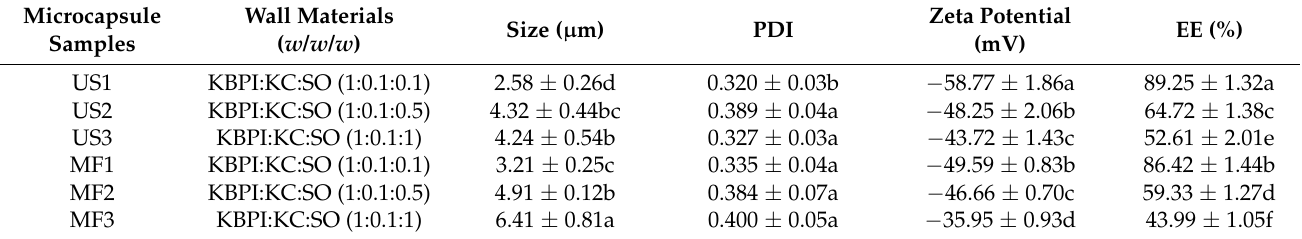
Table 1. Particle size, polydispersity index (PDI), zeta potential and encapsulation efficiency (EE)